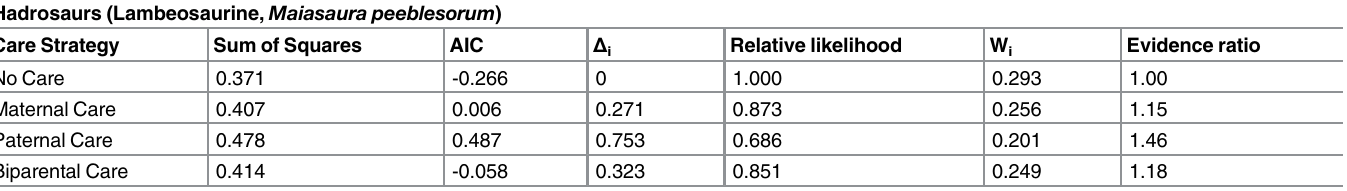
Table 8. Calculated likelihood that the hadrosaurs for which clutch volume data exist show each parental care strategy. Hadrosaurs (Lambeosaurine, Maiasaura peeblesorum ) Care Strategy Sum of Squares Maternal Care Biparental